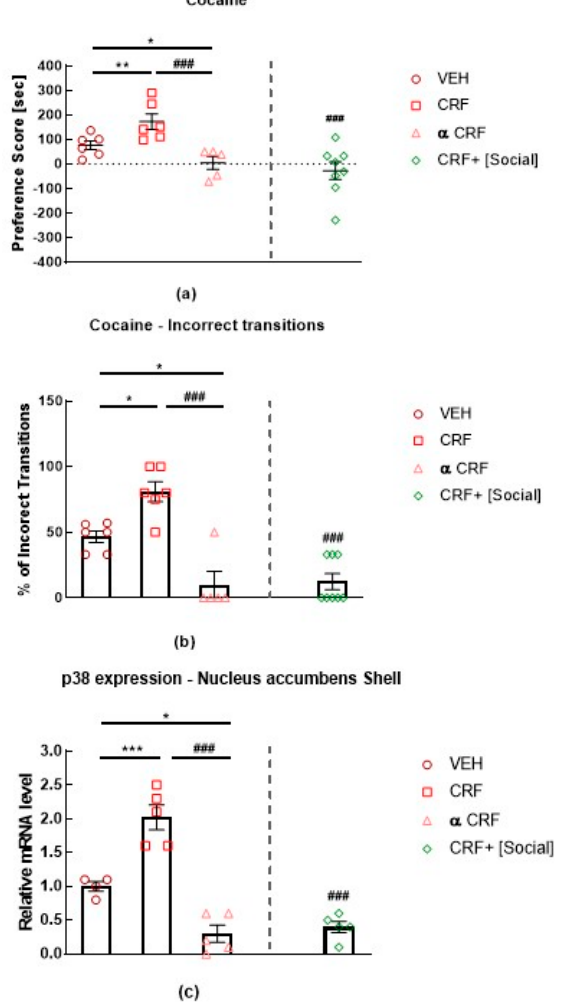
Figure 4. Effects of intracerebroventricular (icv) injections of vehicle, corticotropin-releasing factor (CRF), and alpha-helical CRF ( α CRF) on ( a ) cocaine preference; on ( b ) associated percentage of